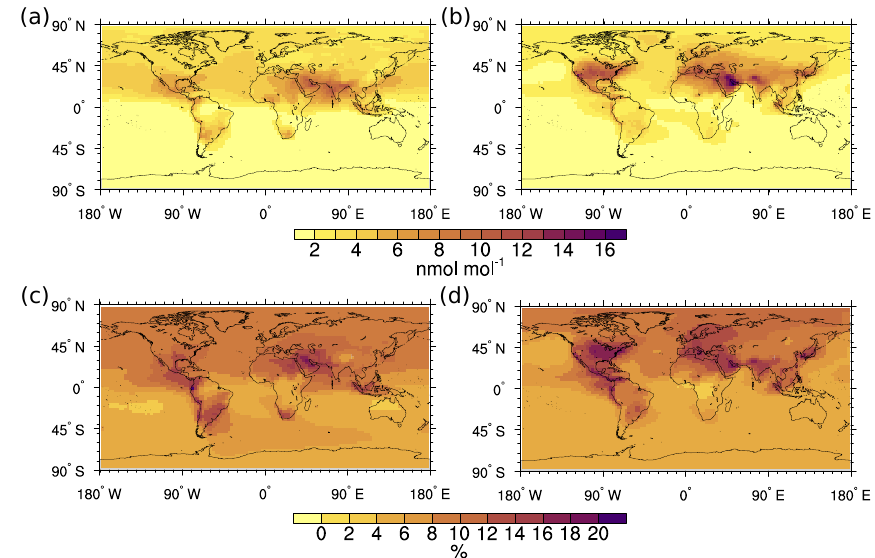
Figure 2. Seasonal average values of the absolute and relative contribution of O tra values (in nmolmol − 1 ) for winter (DJF, a ) and summer (JJA, b ). The lower row shows the DJF (c) and JJA (d) values of the contribution (in